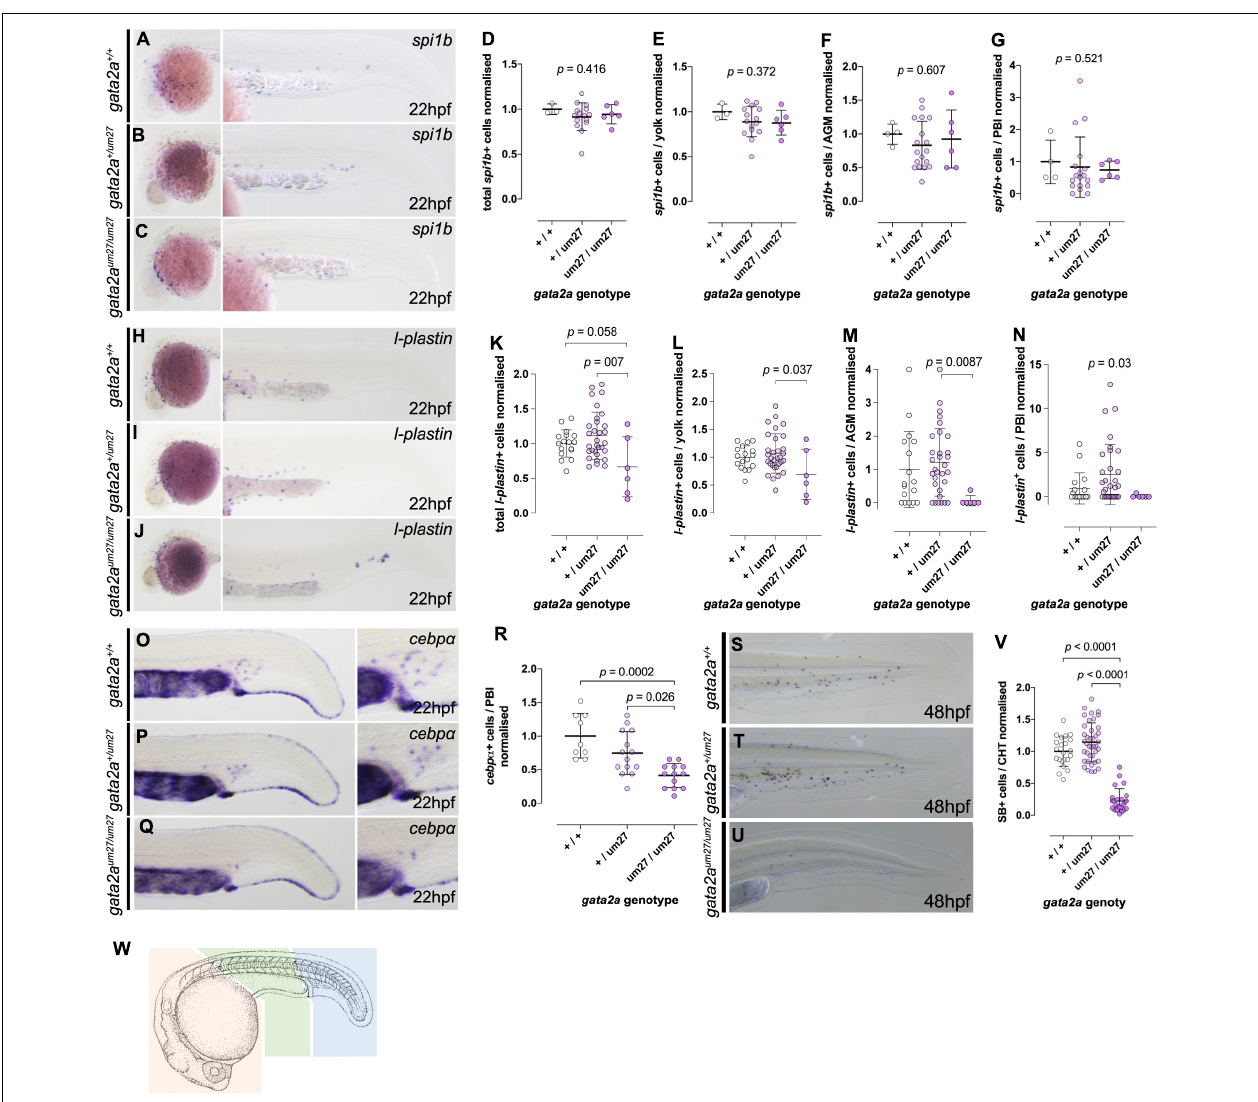
FIGURE 1 | Primitive myeloid development in gata2a mutants at 22 hpf. (A–C) Expression of spi1b by in situ hybridization in 22 hpf embryos. (A–C) Lateral views of the head of the embryos (left) and lateral views of the tails (right), showing normal numbers of myeloid cells. (D–G) Quantifications of total (D) spi1b + cells, and in the yolk (E) , AGM (F) , and the PBI (G) . (H–J) Expression of l-plastin by in situ hybridization in 22 hpf embryos. (H–J) Lateral views of the head of the embryos (left) and lateral views of the tails (right) show decreased l-plastin + cells in gata2a um 27 / um 27 homozygotes. (K–N) Quantifications of l-plastin + cells in the whole embryo (K) , in the yolk (L) , AGM (M) , and the PBI (N) . (O–Q) Lateral views showing cebpa expression in the tail (left) and PBI (right) in 22 hpf embryos. (R) Quantification of cebpa + cells in the PBI of Gata2a um 27 mutants. (S–U) Lateral views of 48 hpf mutant embryos stained with SB, which labels granulocytes. (V) Quantification of SB+ cells